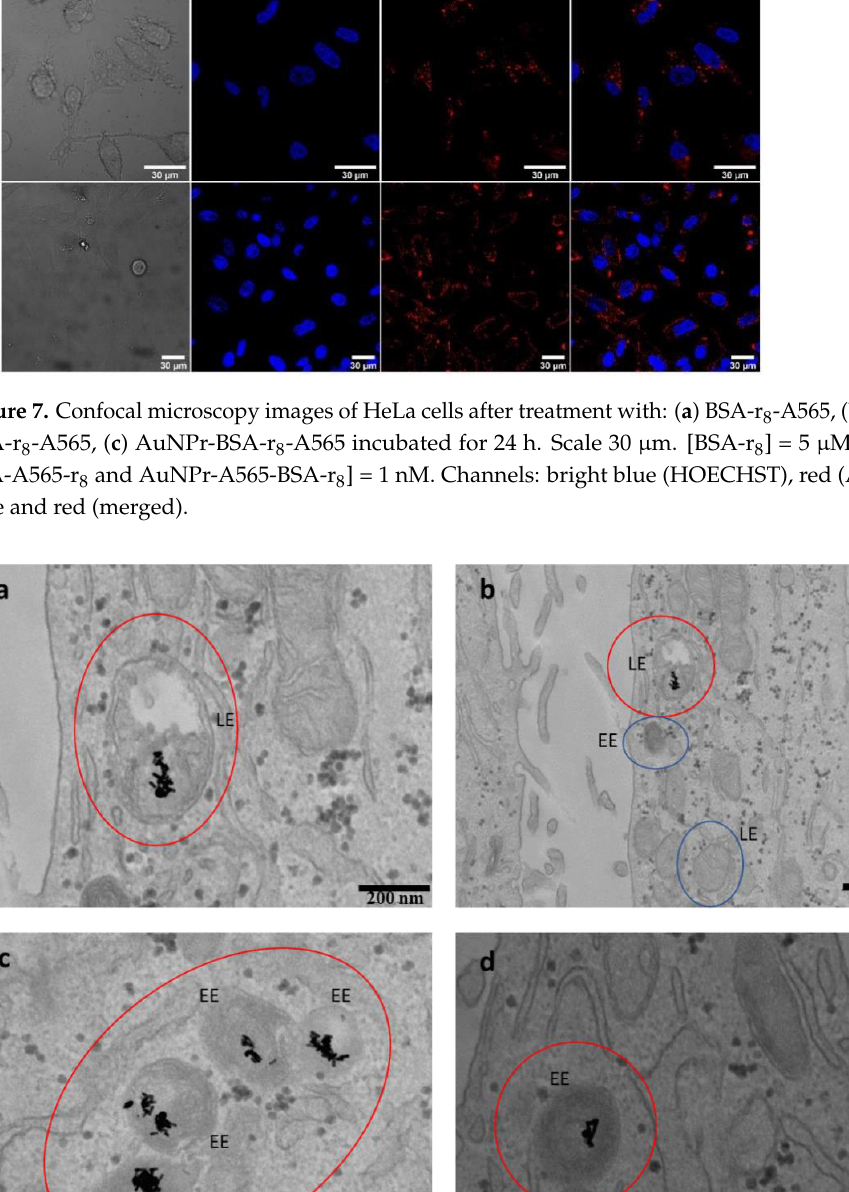
Figure 9. TEM images of HeLa cells after treatment with AuNPr-BSA-r 8 incubated for 24 h ( a – d ). Red circles show the internalized AuNPs. EE: early endosomes and LE: late endosomes. Blue circles showing examples of vacant LE or EE.